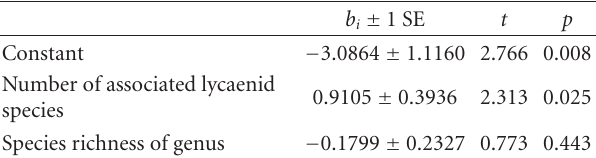
Figure 1: Rank-frequency plot of ant genera of the world involved in myrmecophilous associations of Lycaenidae butterflies, based on 927 record pairs of 497 butterfly species with 54 ant genera. Rank 1: ant genus with largest number of associated lycaenid species reported. Ranks 47 to 54: ant genera with only one associated lycaenid species known thus far. Filled diamonds: ant genera only known to be involved in mutualistic interactions with butterflies; open squares: ant genera that also serve as hosts for ant-parasitic Lycaenidae larvae (with genus name included; figure in parentheses: number of confirmed ant-parasitic lycaenid species). Note log-scale of y -axis. Table 3: Results of a bivariate logistic regression, modelling the incidence of ant-parasitic associations within an ant genus ( N = 54 ant genera), in relation to species richness and number of nonparasitic associations with lycaenid immatures (both log- transformed) per ant genus. Given are the regression coe ffi cients t and p values. Overall b i , their standard errors and corresponding = 6 . 577; P = 0 . model score: χ 2 2df